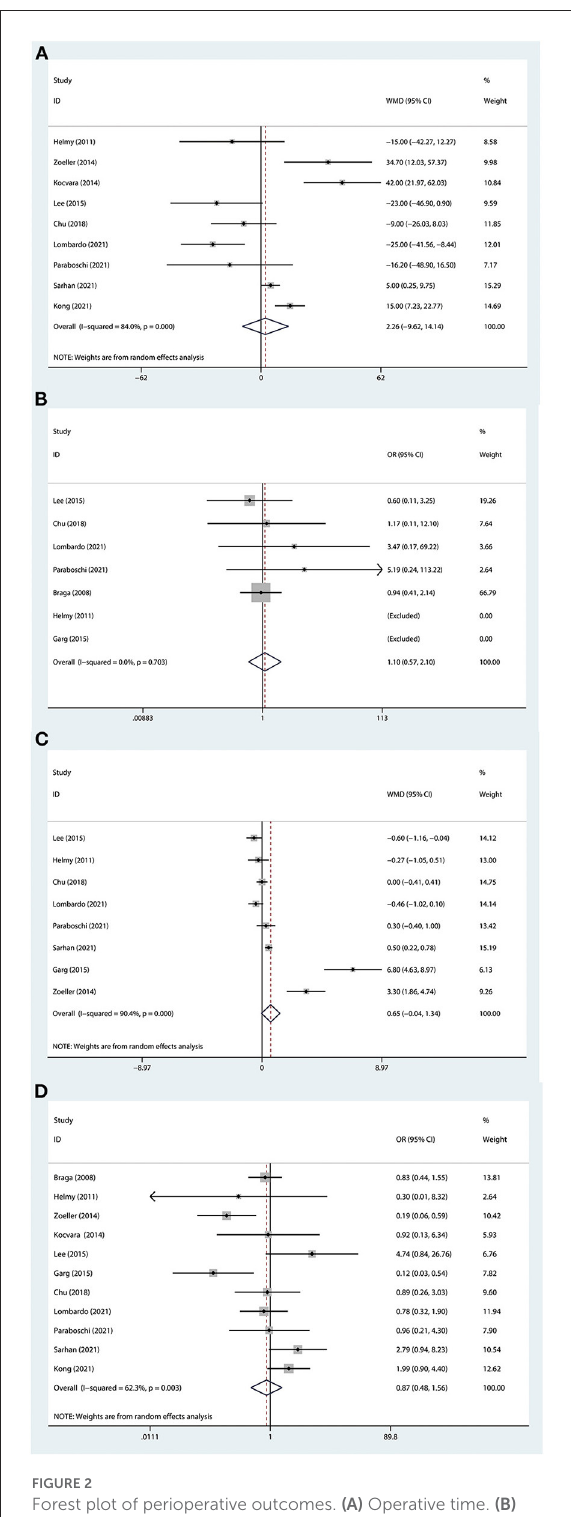
FIGURE2 Forest plot of perioperative outcomes. (A) Operative time. (B) Operative success rate. (C) Length of hospital stay. (D) Complication. The horizontal lines represent 95% CI. The intersection of diamond and vertical line means that the difference is not statistically